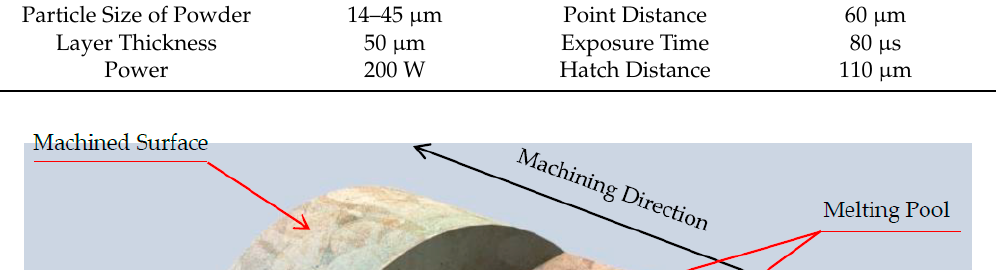
Table 1. Selective Laser Melting process parameters.